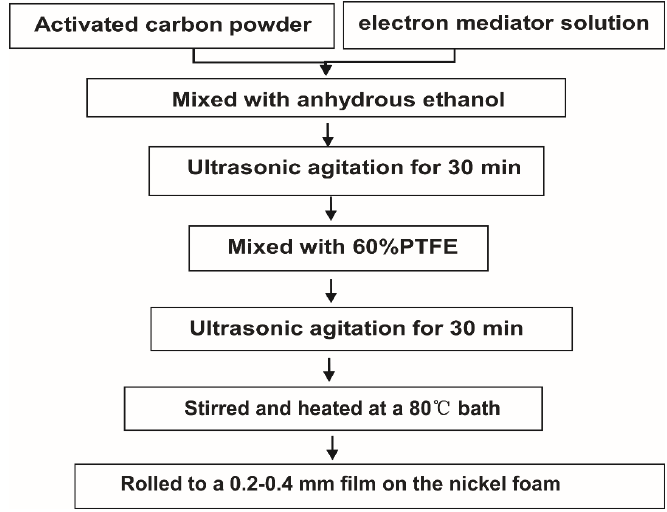
Figure 7. Fabrication procedures for the immobilized activated carbon anode.